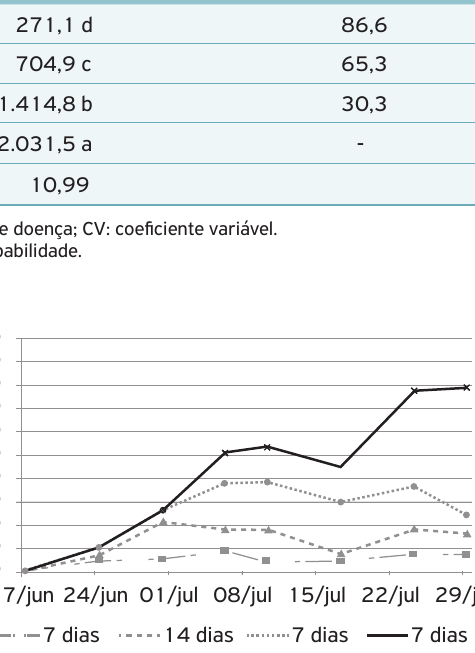
Figura 2. Curvas de progresso da doença observadas para diferentes momentos de aplicação de fungicida para o controle da ferrugem da folha, em Londrina (PR),